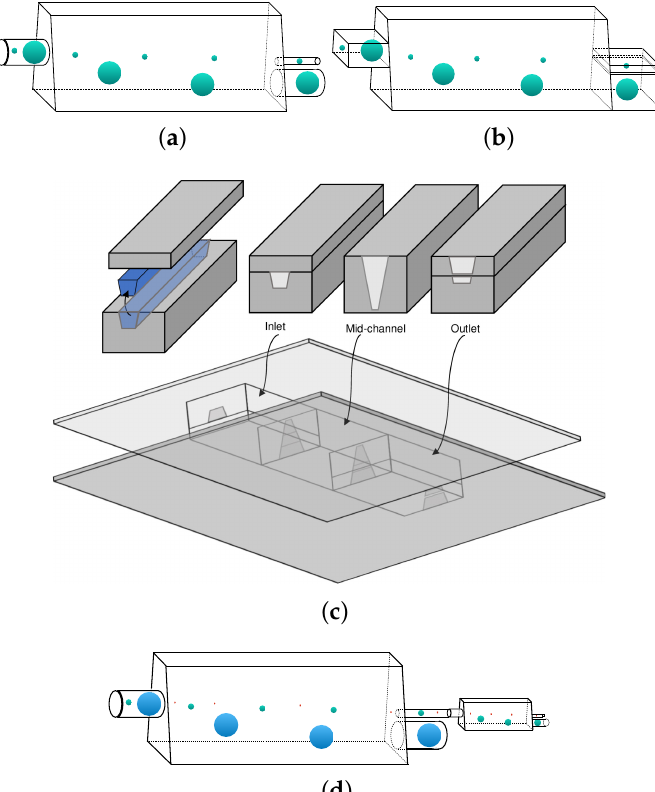
Figure 10. Illustration of the proposed sorting microdevice. ( a ) A micro-capillary consisting of the sorting trapezoidal channel with cylindrical inlet and outlets. ( b ) A microfluidic device with trapezoidal inlet and outlets. ( c ) Fabrication of the microfluidic device shown in ( b ). ( d ) A two-stage sorting device for the separation of capsules with three different